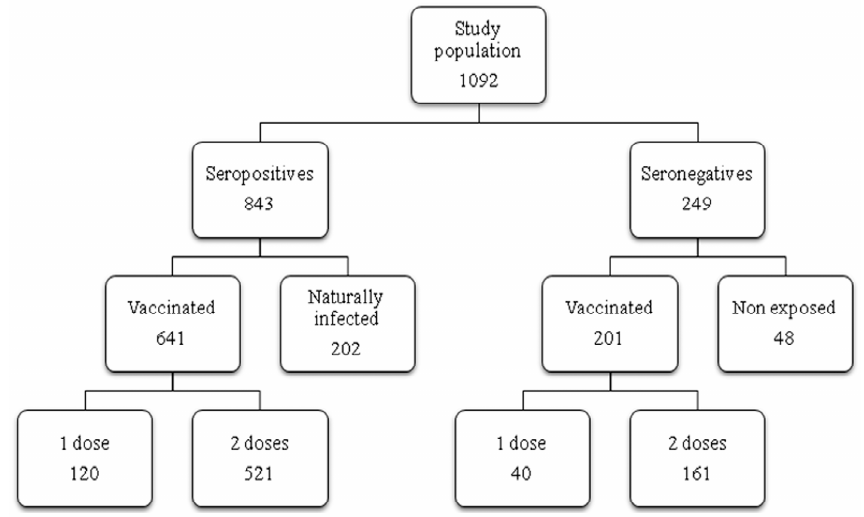
Figure 1. Flow diagram of the study population. Schematic representation of the study population enrolled in the study with the relative number of subjects in each group.